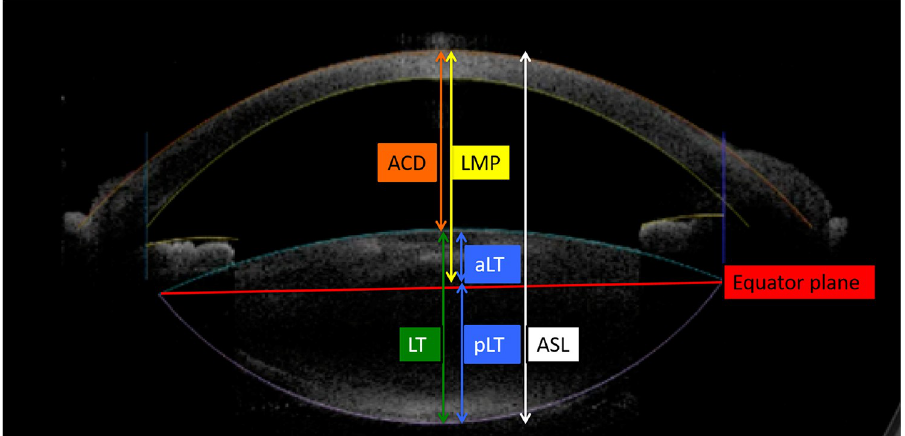
Fig 1. Biometric measurements provided by 3-dimensional optical coherence tomography (3-D OCT). The 3-D OCT images show the scanned capsule, which is an imaginary line of the crystalline lens visualized from the anterior and posterior capsule, provided by the built-in algorithm of the laser system. The equator plane is a straight line that connects both ends of the imaginary lines. Anterior chamber depth (ACD) is determined by calculating the distance along the visual axis between the corneal epithelium and anterior lens surface by OCT. The lens meridian parameter (LMP) is the vertical distance from the corneal apex to the equator plane of the crystalline lens. The anterior segment length (ASL) was calculated by adding the lens thickness (LT) to the ACD. The crystalline lens was also analyzed by dividing it into an anterior part (aLT) and posterior part (pLT), bordered by the equator plane.